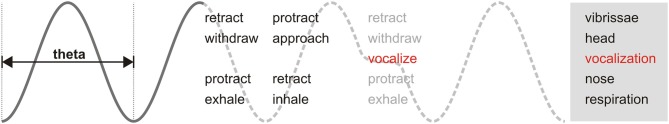
Theta-linked orofacial behaviors in rodents. Periodic motor actions during active behavioral states are coordinated in phase along a theta frequency rhythm. When vocalizations occur (red), they are inserted immediately after the end of inhalation. Adapted after Welker (1964) and Kepecs et al. (2006).